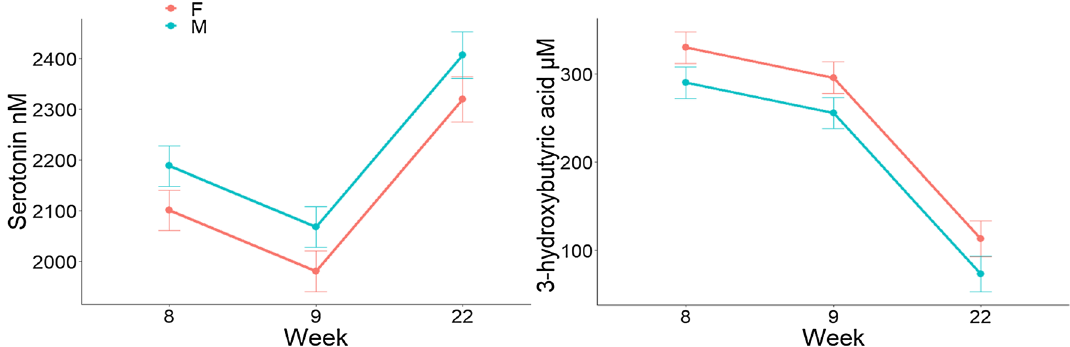
Figure 3. Least squared means and SE of serum 3-hydroxybutyric acid and serotonin concentrations in female (F) and castrated male (M) pigs at week 8, 9 and